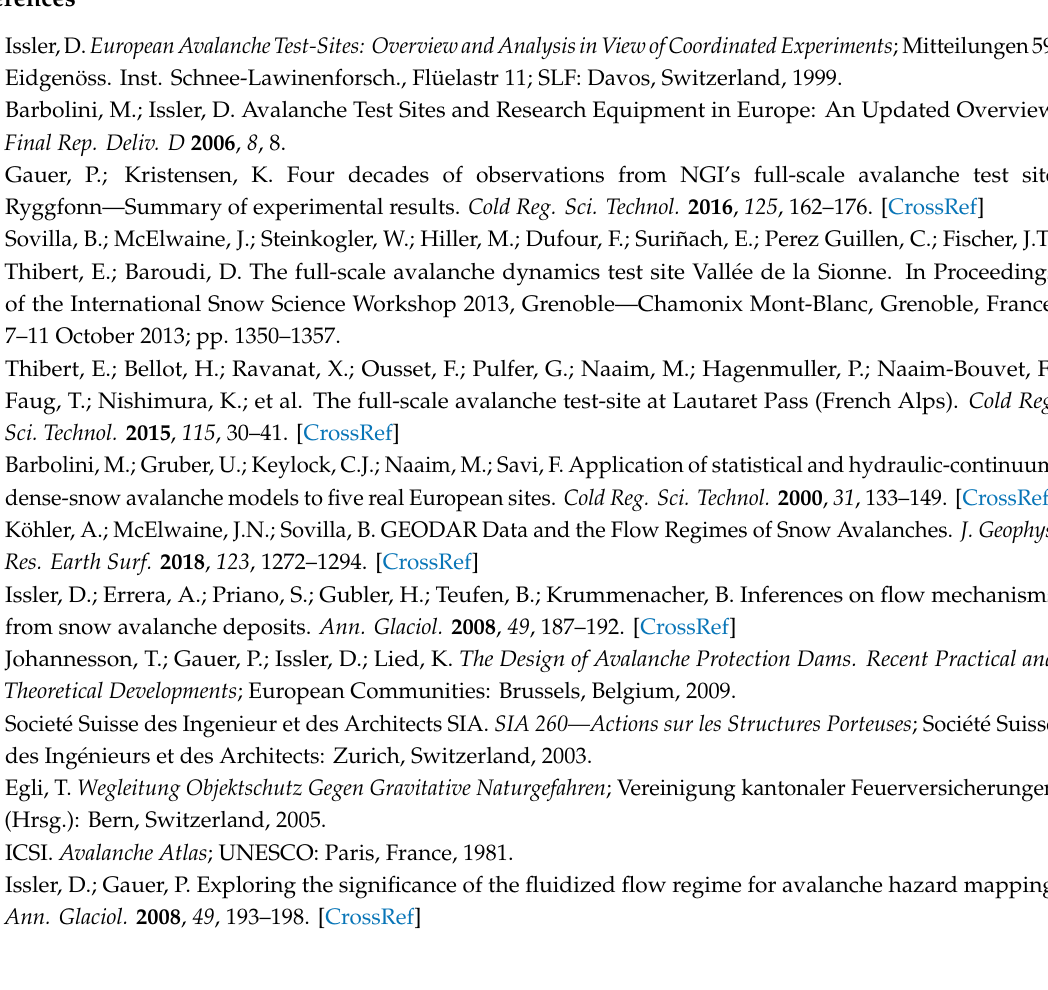
Figure S33. 20 January 2014: impact forces recorded by load transducer n. 10; Figure S34. 30 April 2014: impact forces recorded by load transducer n. 01; Figure S35. 30 April 2014: impact forces recorded by load transducer n. 02; Figure S36. 30 April 2014: impact forces recorded by load transducer n. 03; Figure S37. 30 April 2014: impact forces recorded by load transducer n. 04; Figure S38. 30 April 2014: impact forces recorded by load transducer n. 05; Figure S39. 30 April 2014: impact forces recorded by load transducer n. 06; Figure S40. 30 April 2014: impact forces recorded by load transducer n. 07; Figure S41. 30 April 2014: impact forces recorded by load transducer n. 08; Figure S42. 30 April 2014: impact forces recorded by load transducer n. 09; Figure S43. 30 April 2014: impact forces recorded by load transducer n. 10; Figure S44. 7 December 2010: total force on the impacted area; Figure S45. 5 March 2011: total force on the impacted area; Figure S46. 17 April 2013: total force on the impacted area; Figure S47. 20 January 2014: total force on the impacted area; Figure S48. 30 April 2014: total force on the impacted